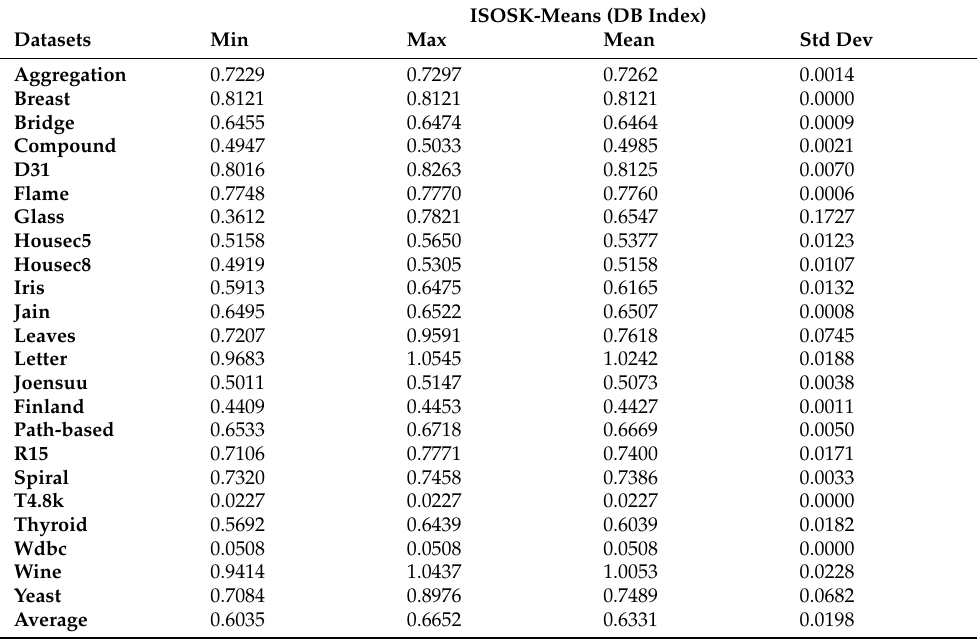
Table 8. Computational results of ISOSK-means on 23 real-life datasets.